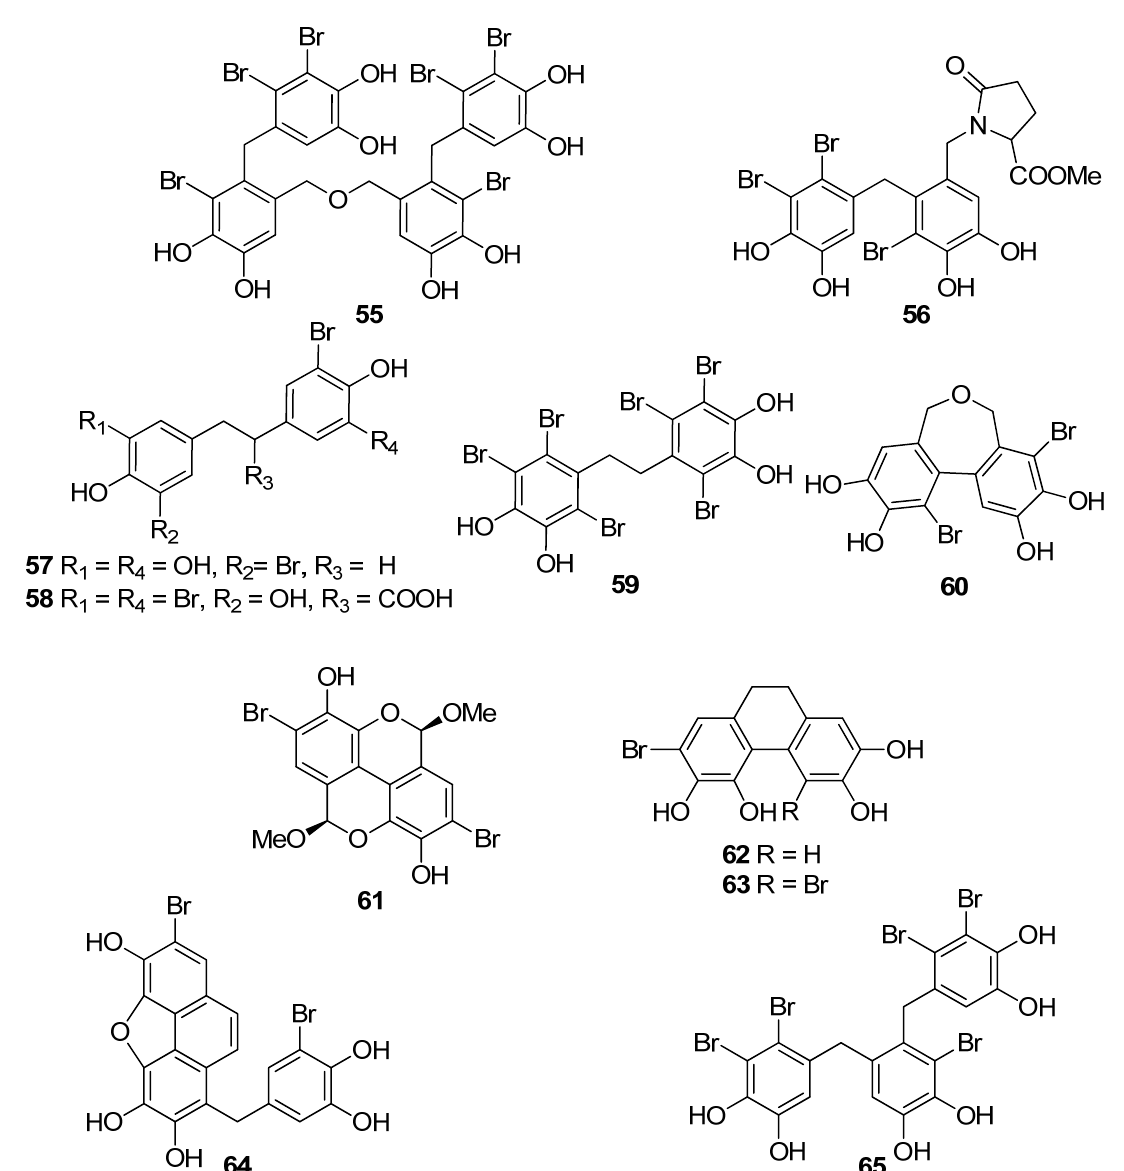
Figure 4. Chemical structures of compounds 55 – 65 .